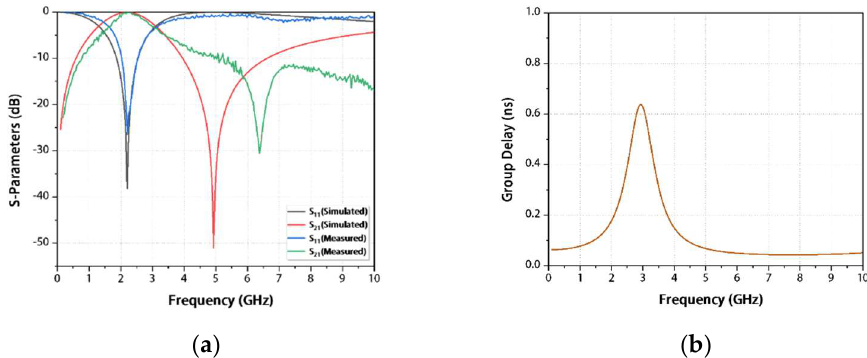
Figure 7. Simulation and measurement results: ( a ) parameters S 11 and S 21 ; ( b ) group delay.